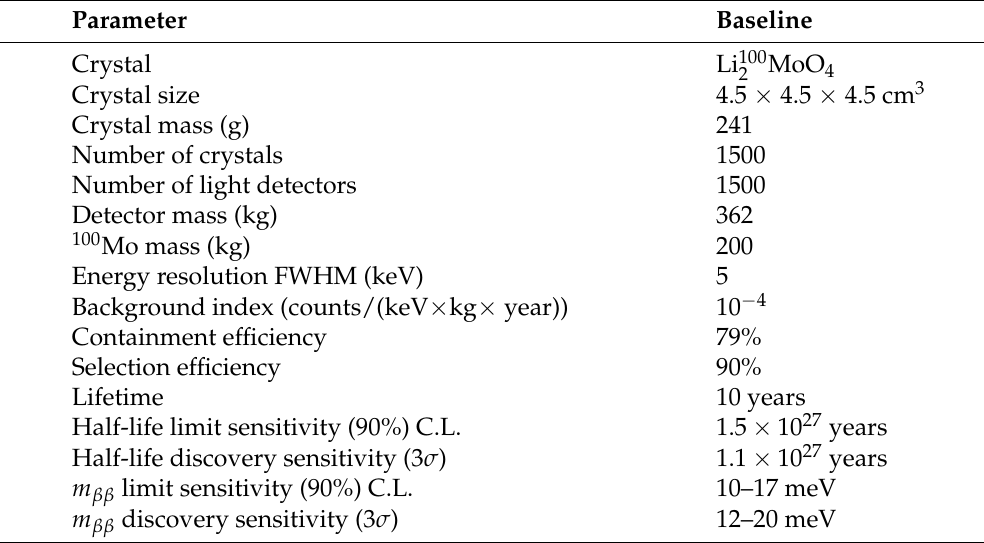
Table 2. Main parameters of the conservative baseline CUPID detector design. The values are taken from